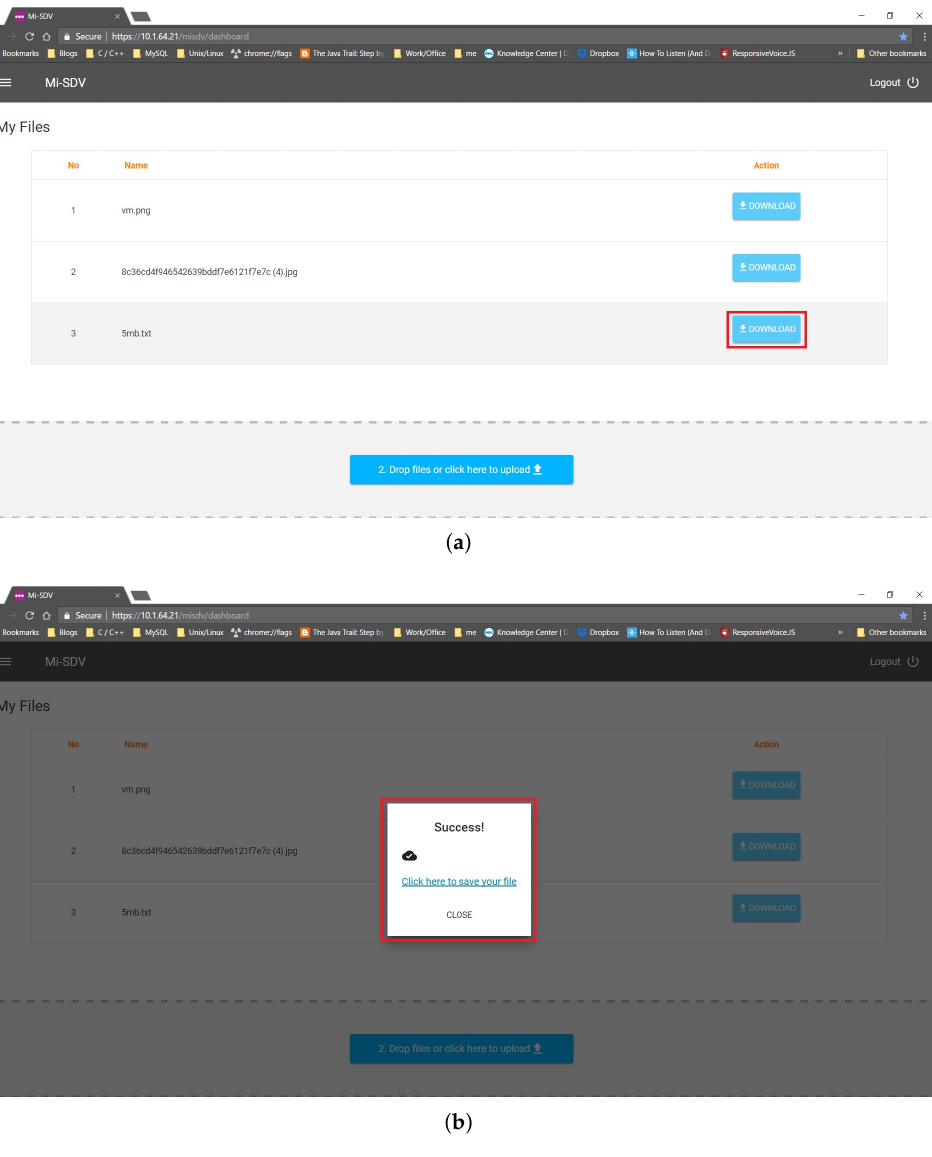
Figure 9. Retrieving a document. ( a ) Select file to download; ( b ) Download